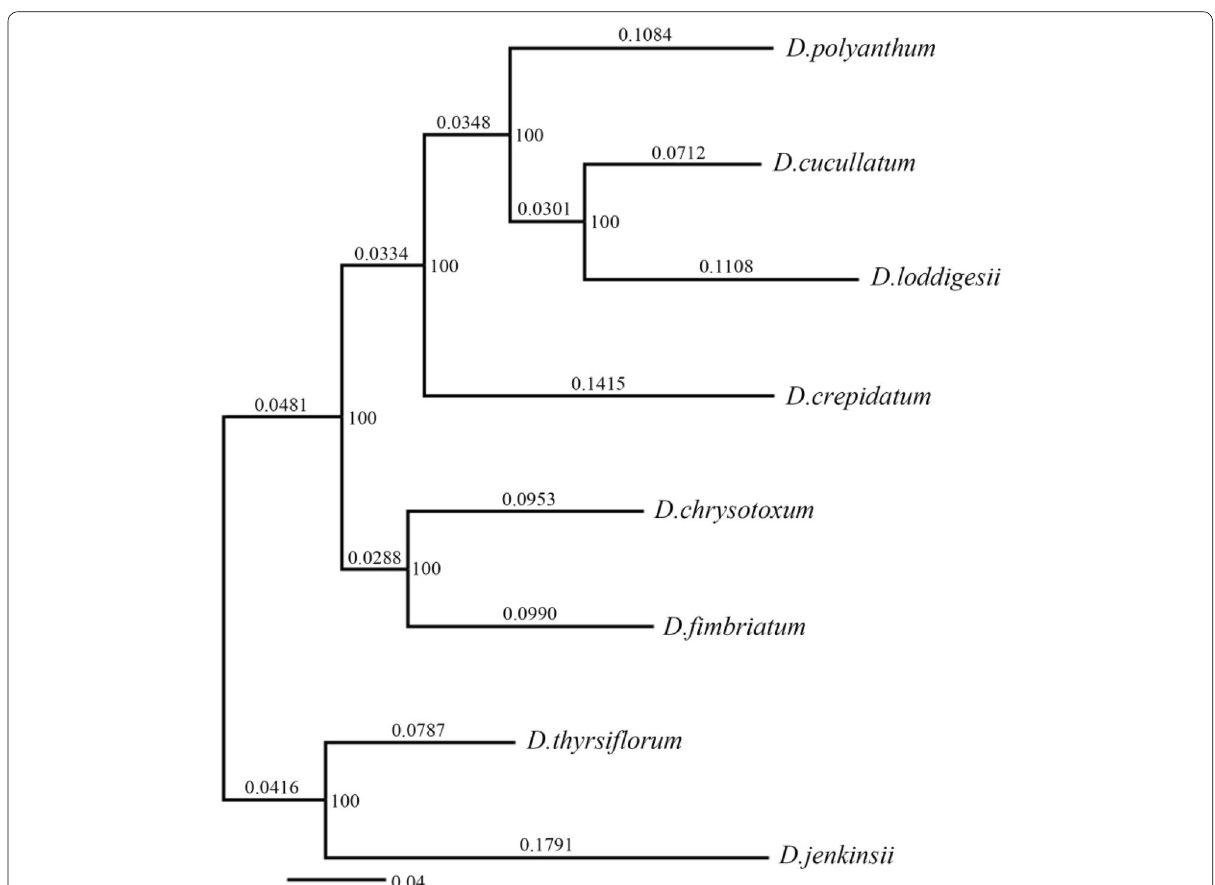
Fig. 1 Phylogenetic tree of the eight Dendrobium species. The numerical values above the nodes on the phylogenetic tree indicate that the support rate for there being a split between species is greater than 50%, and the value on the phylogenetic tree branch represents the distance between two adjacent